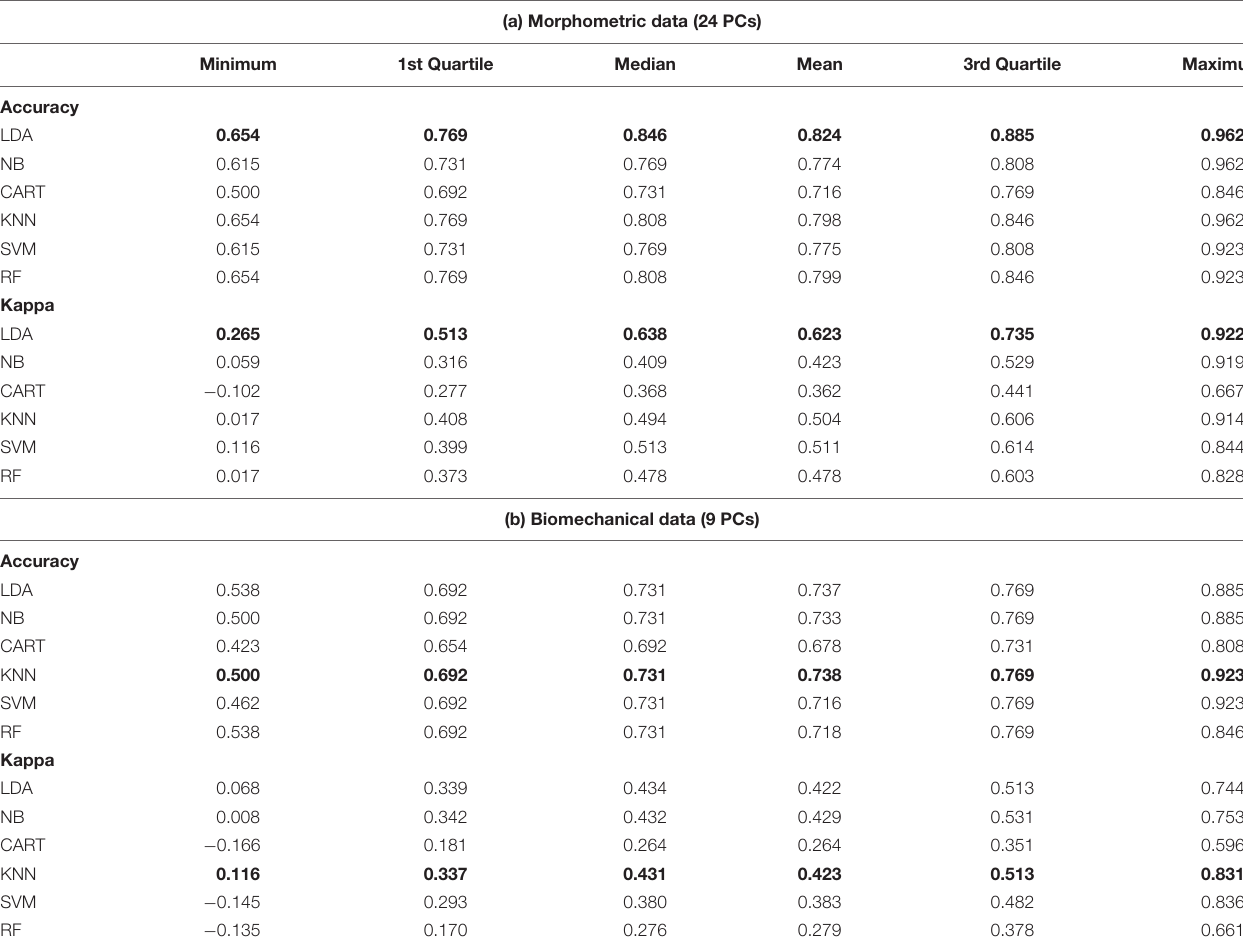
TABLE 2 | Summary statistics of the “leave-group-out” cross-validation procedure for the accuracy and Cohen’s kappa values for all the tested models (best models in